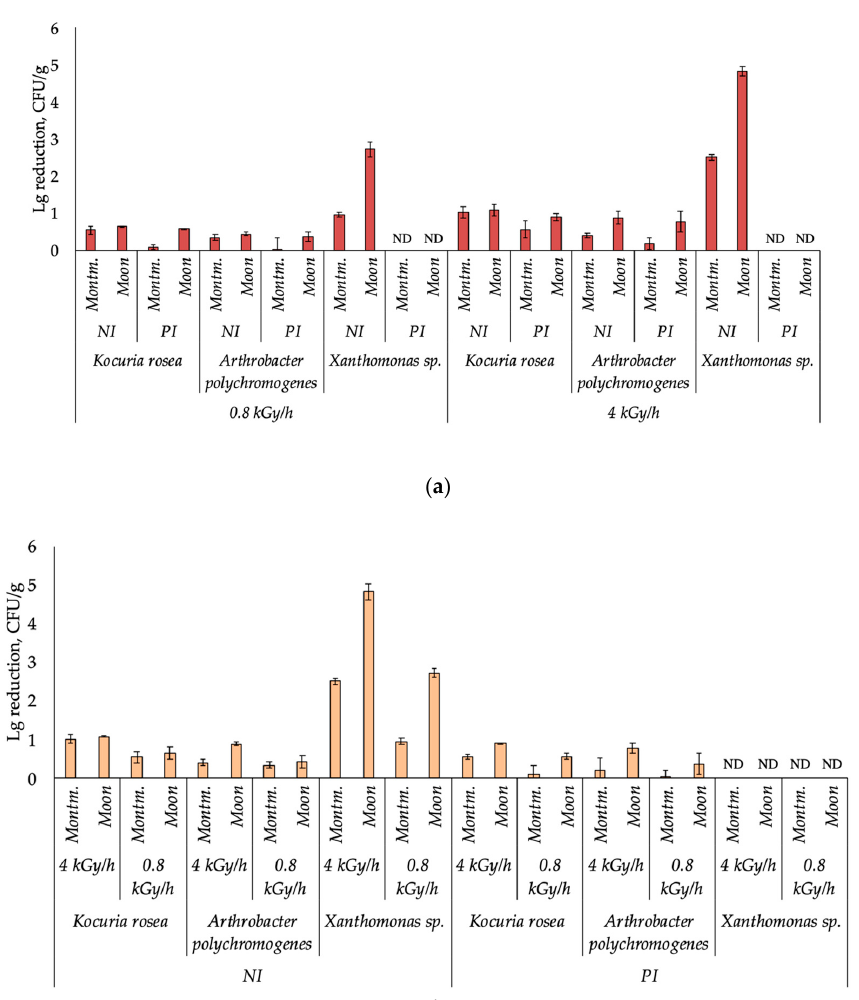
Figure 1. Decrease in the number (logarithmic reduction) of viable bacteria under different conditions of irradiation (subfigures ( a , b ) are based on the same data, combined in different ways for comparison convenience). Montm.—variants immobilized on montmorillonite; Moon—variants immobilized on lunar dust analog; NI—non-pre-irradiated strains; PI—pre-irradiated strains. ND—no data.